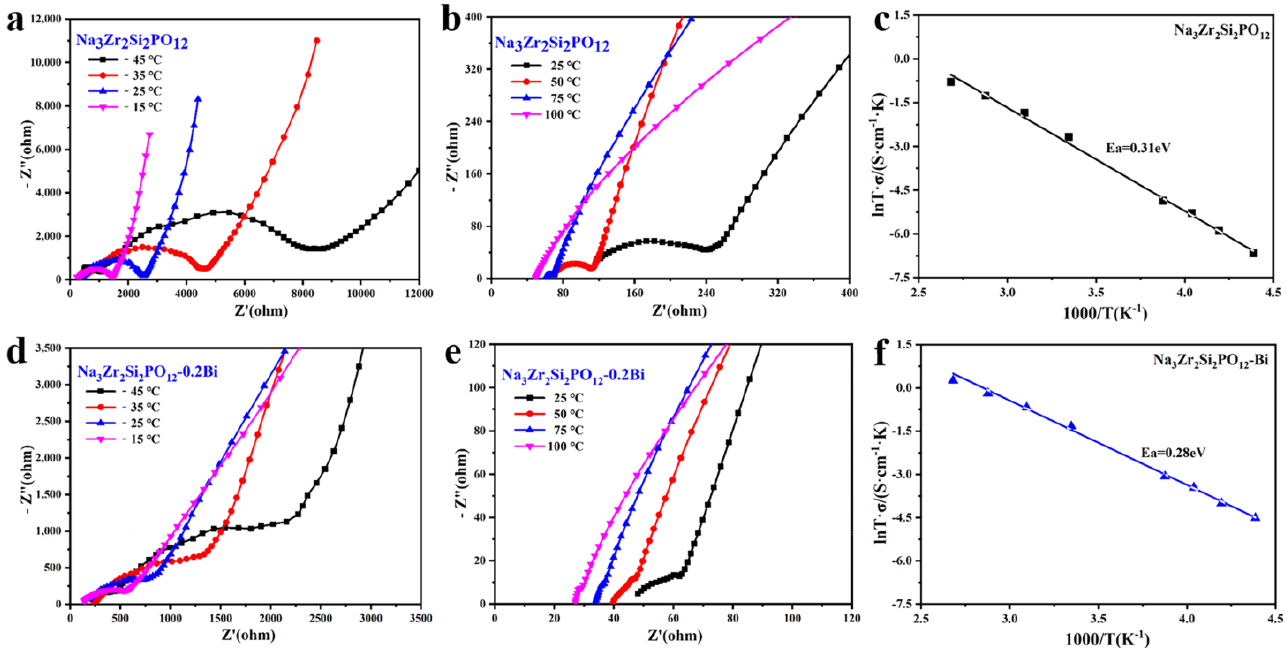
Figure 4. ( a , b ) Low-temperature, room-temperature and high-temperature Nyquist plots of Na 3 Zr 2 Si 2 PO 12 electrolyte. ( c ) Arrhenius plot of Na 3 Zr 2 Si 2 PO 12 electrolyte. ( d , e ) Low-temperature, room-temperature and high-temperature Nyquist plots of Na 3 Zr 2 Si 2 PO 12 - electrolyte. ( f ) Arrhenius plot of Na 3 Zr 2 Si 2 PO 12 -0.2Bi electrolyte.